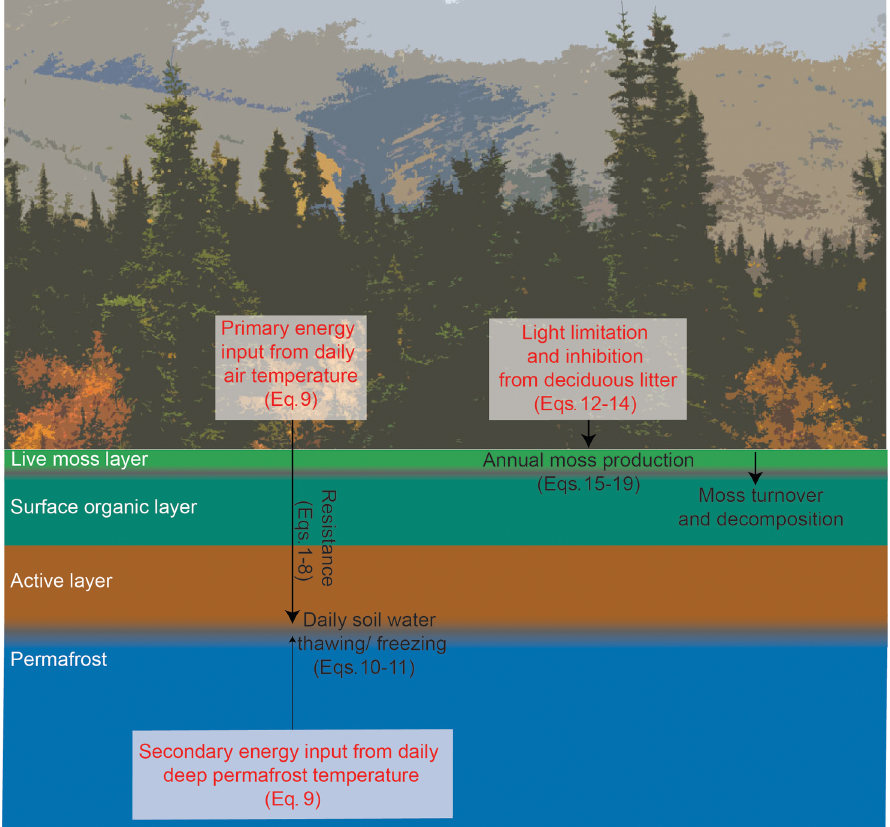
Figure 1. Conceptual diagram of the permafrost and soil-surface organic layer module. State variables are in white, processes are described in black, and forcing variables are in